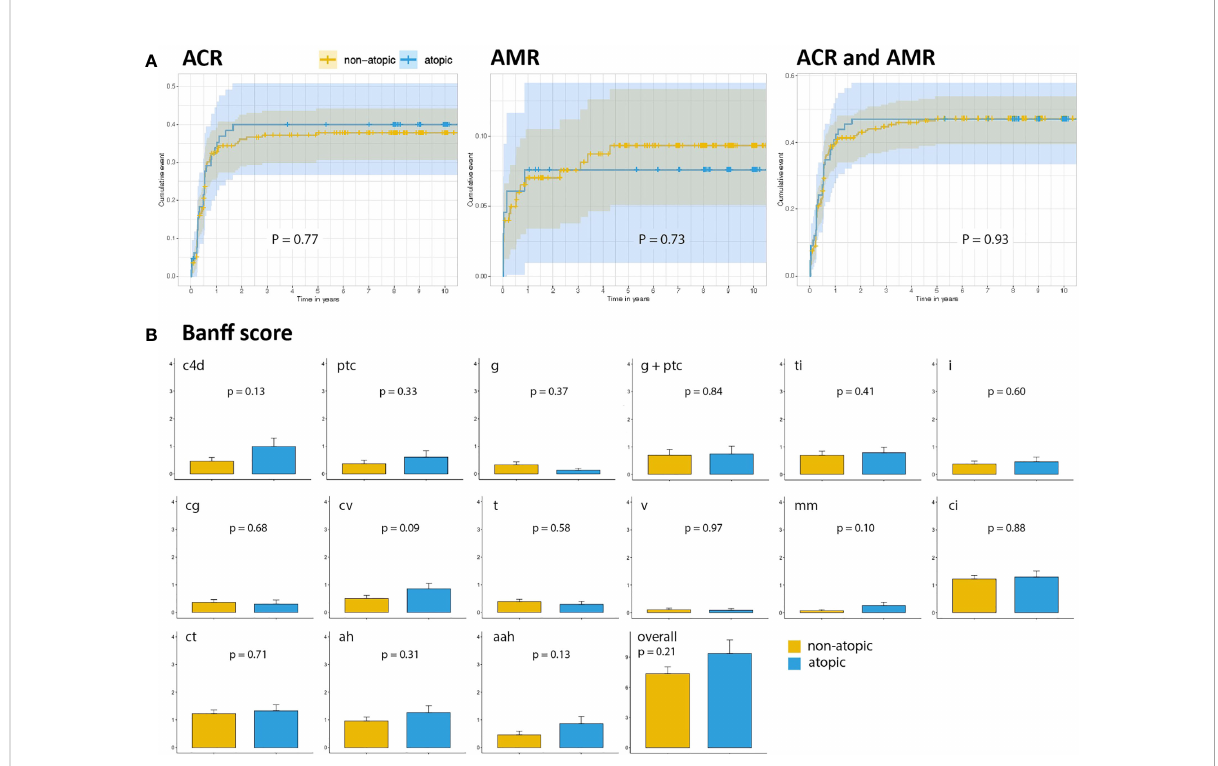
FIGURE 3 Biopsy-proven rejections in atopic and non-atopic groups. (A) Ten-year cumulative events of ACR and AMR according to the atopic status. (B) Banff score comparison of kidney biopsies in non-atopic and in atopic patients. Bars represent the average score of all biopsies performed in the non-atopic and atopic patients during follow-up. Intervals represent the standard error of the mean. C4d, C4d deposition; ptc, peritubular capillaritis; g, glomerulitis; ti, total in fl ammation; i, interstitial in fl ammation; cg, glomerulopathy; cv, fi brous intimal thickening; t, tubulitis; v, intimal arteritis; mm, mesangial matrix increase; ci, interstitial fi brosis; ct, tubular atrophy; ah, arteriolar hyalinosis; aah, alternative arteriolar